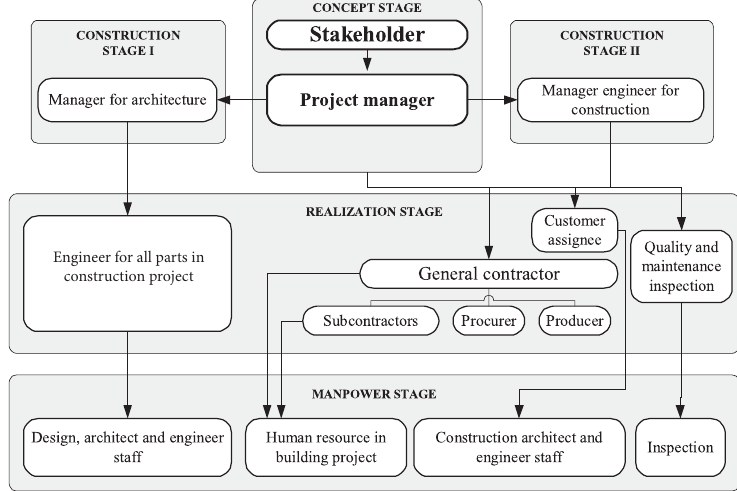
Fig. 1. Team of project and role of the project manager in construction